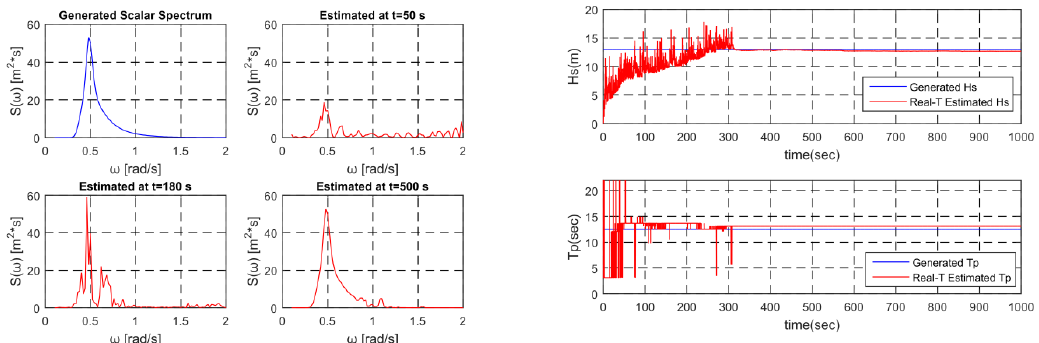
Figure 25. Generated and estimated spectrum/Evolution of parameters (Sea sate 4, Hs = 13 m, Tp = 13 s).